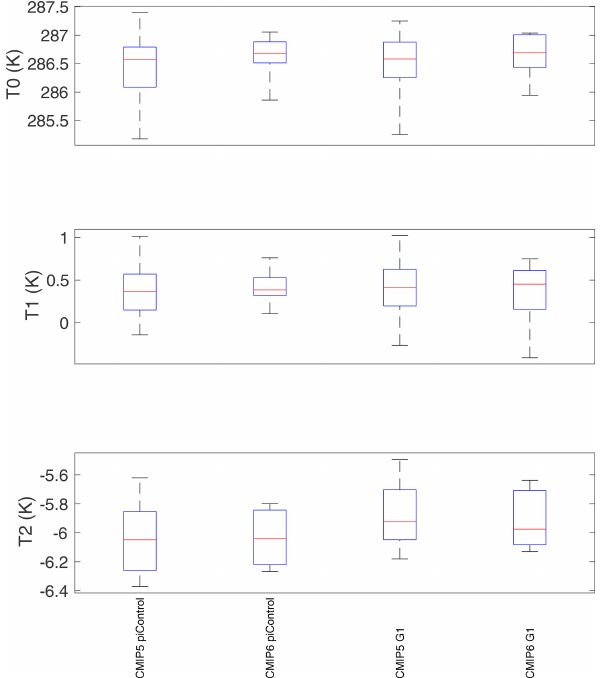
Figure 7. Ensemble ranges for global mean temperature ( T 0 ), the interhemispheric temperature gradient ( T 1 ), and the Equator-to-pole temperature gradient ( T 2 ), as defined in Eq. (1) (Ban-Weiss and Caldeira, 2010; Kravitz et al., 2016). Red lines indicate ensemble medians, blue boxes are the interquartile ranges, and black whiskers indicate total ranges.